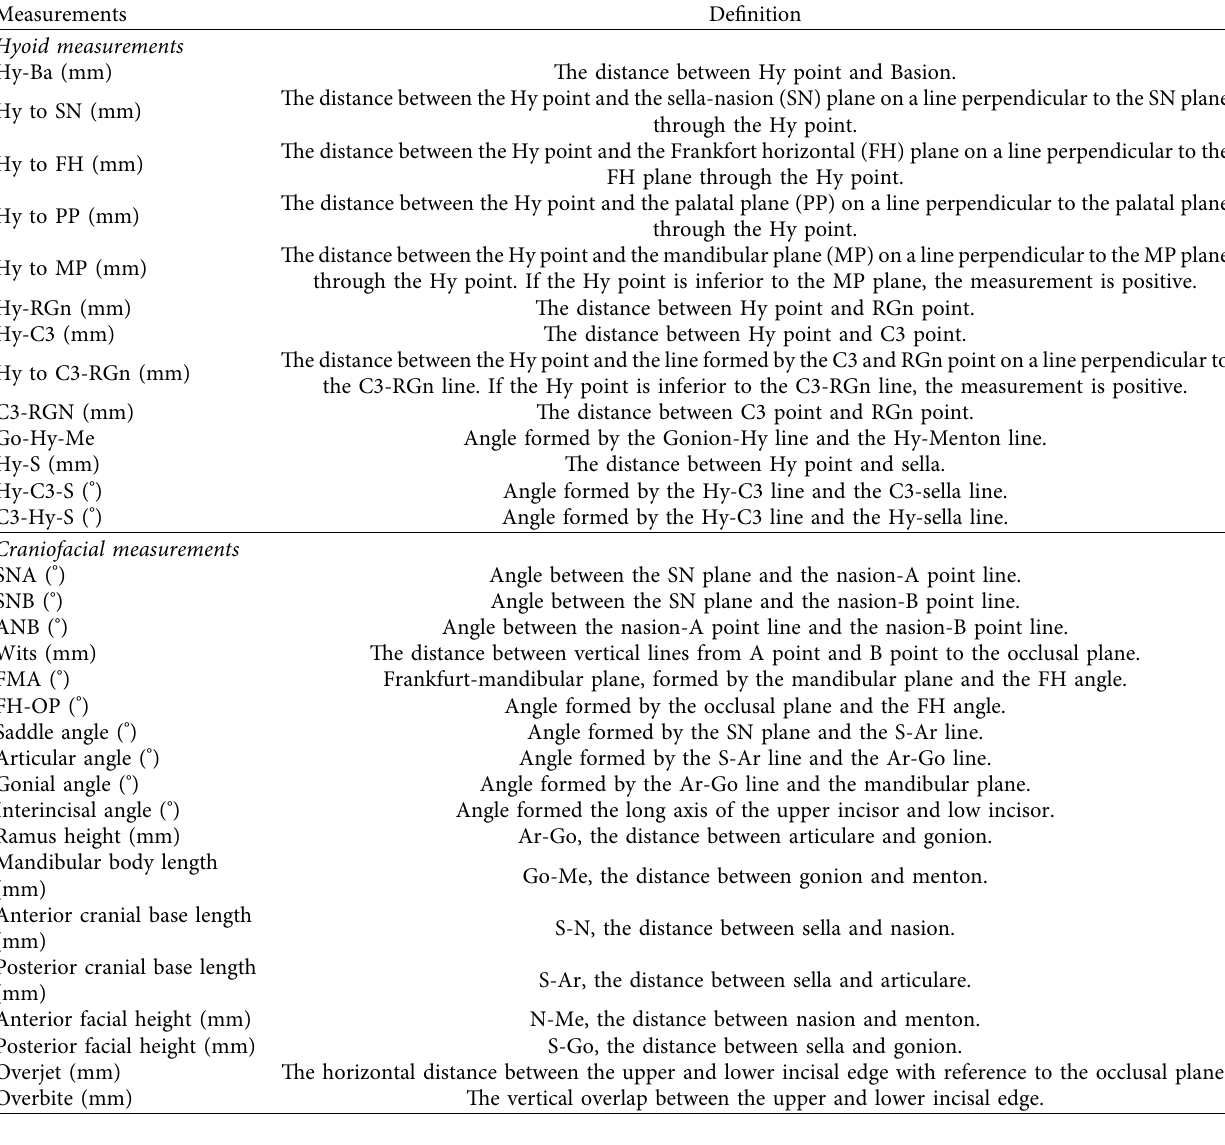
Table 1: Hyoid and craniofacial measurements from cephalograms in this study.